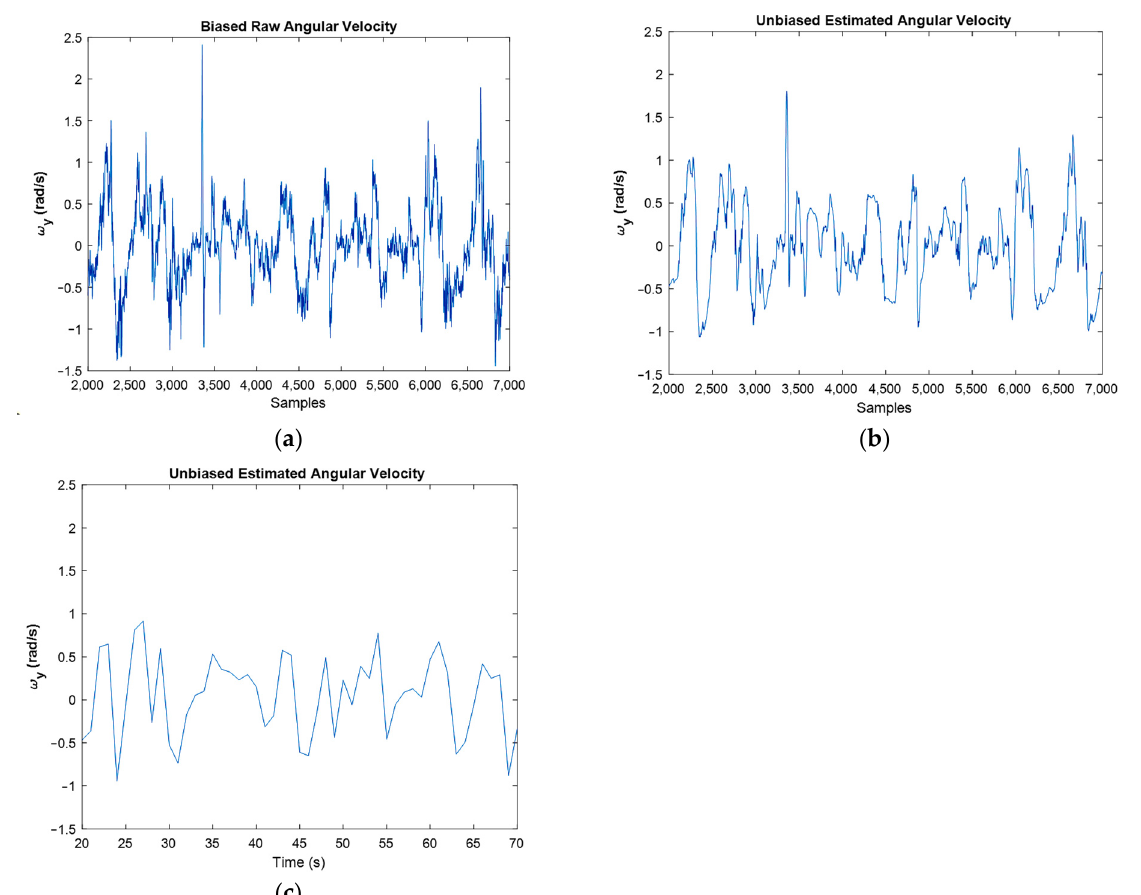
Figure 14. Raw angular velocities ( a ), against estimated angular velocities for samples ( b ), and for last amounts of estimation ( c ).